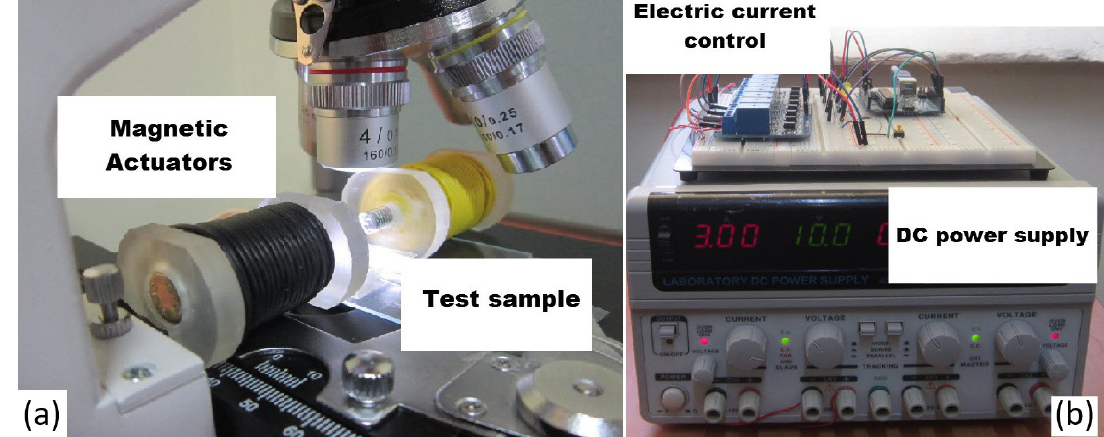
Figure 10. ( a ) Experimental setup used for in vitro studies of aggregation (microscope and coils), ( b ) the current control